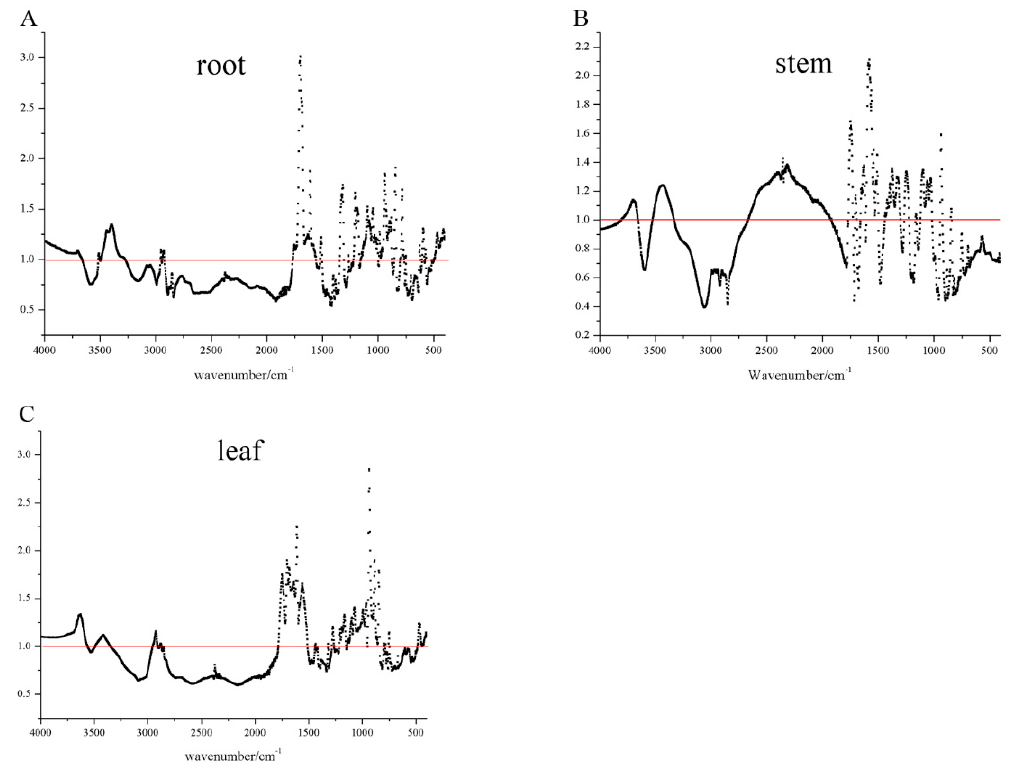
Figure 3. VIP variable screening for root ( A ), stem ( B ), and leaf ( C ) (VIP of more than 1 was selected).